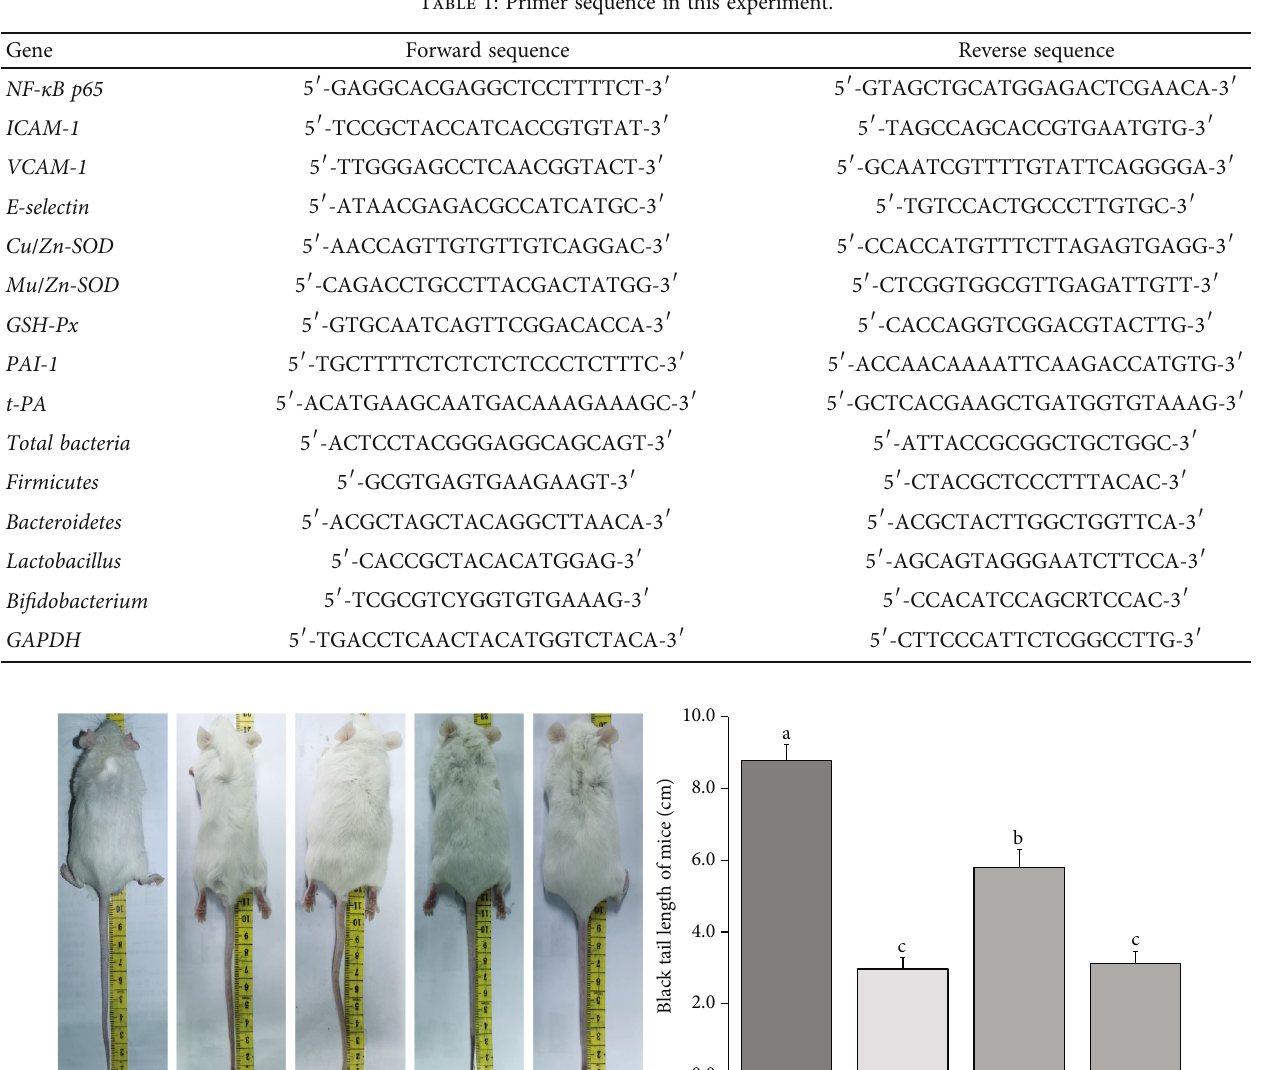
Table 1: Primer sequence in this experiment.